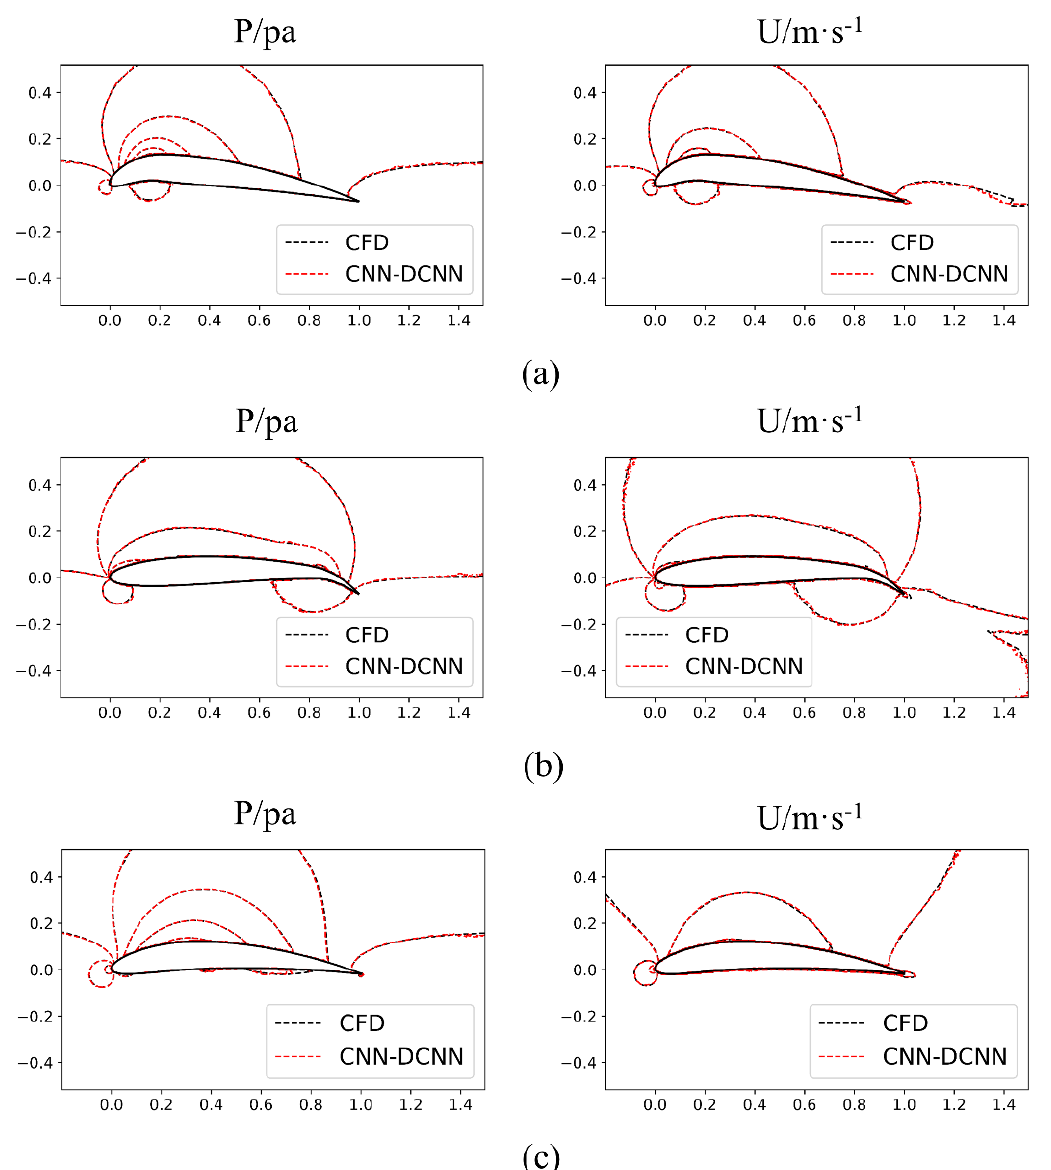
Figure 13. Comparison of the pressure and velocity contours for three cases: ( a ) NACA9212, AOA = 4°, Re = 3 × 10 6 ; ( b ) NACA8812, AOA = 4°, Re = 5 × 10 6 ; ( c ) NACA7412, AOA = 1°, Re = 7 × 10 6 .